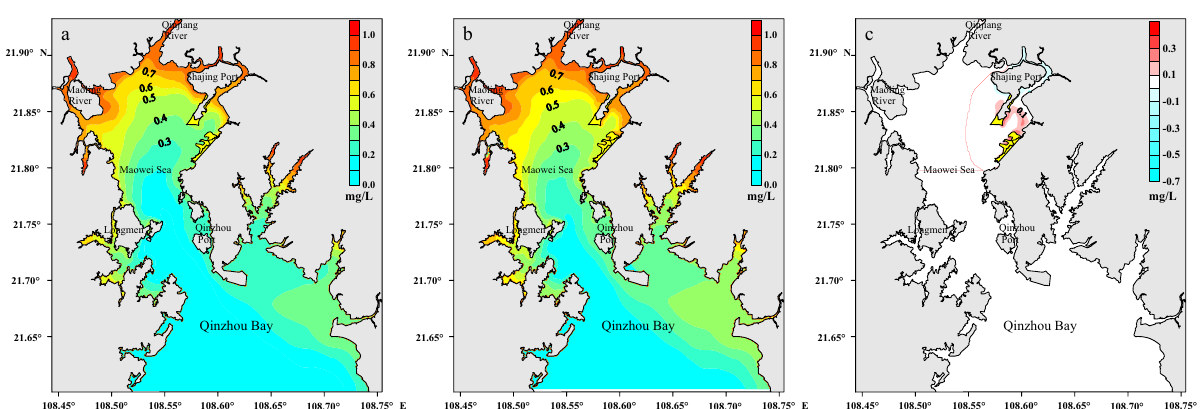
Figure 6. Distribution of pollutants in the Maowei Sea area at the residence half-life time before the project (a) , after the project (b) and the variation of the pollutant concentration after project (c) . These figures were drawn with Surfer10 Software (https:// www. golde nsoft ware. com/ produ cts/ surfer).